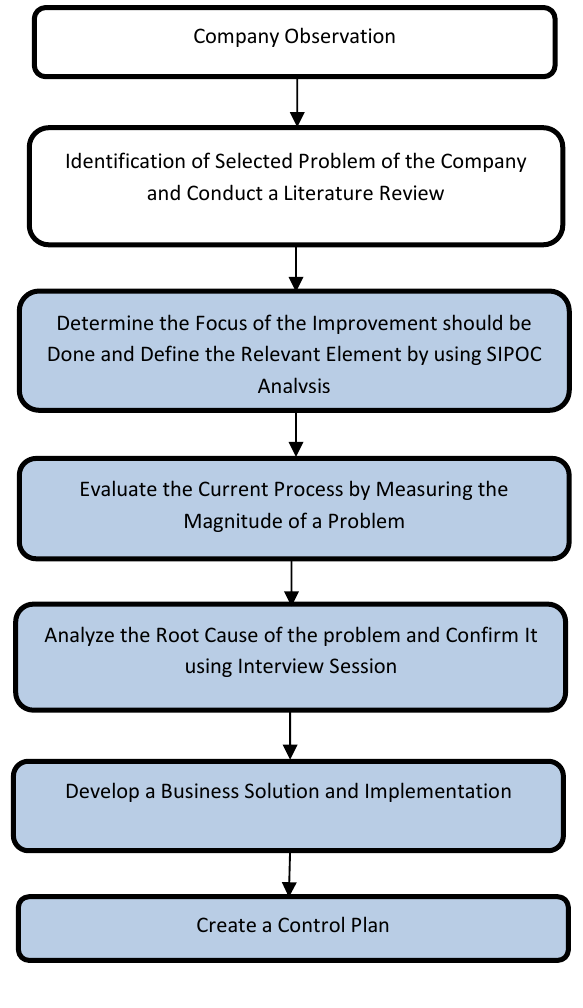
Figure 2: The DMAIC Structure and the